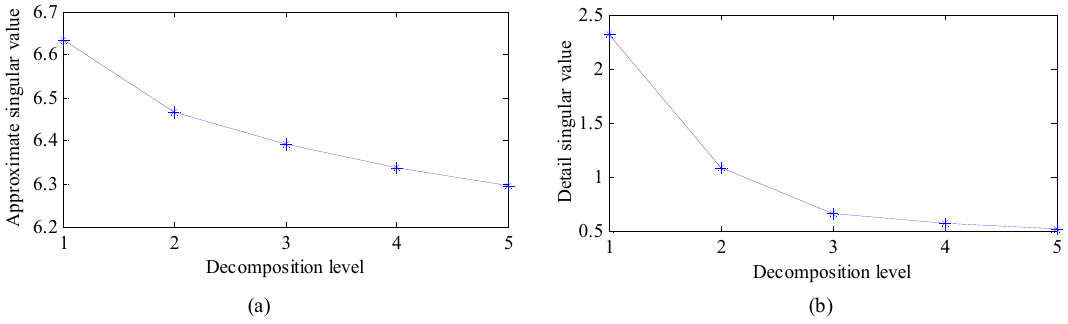
Figure 11. The singular values at each decomposition level: ( a ) Approximate singular values; ( b ) Detail singular values.